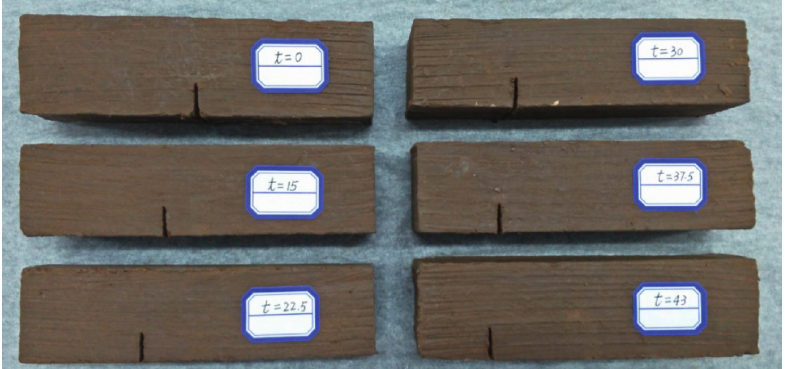
Figure 3: The prepared CCB specimens with different offset notches: C ˆ 0.717 ( t ˆ 43 mm), C ˆ 0.625 ( t ˆ 37.5mm), C ˆ 0.5 ( t ˆ 30 mm), C ˆ 0.375 ( t ˆ 22.5mm), C ) ˆ 0.25 ( t ˆ 15 mm), and C ˆ 0 ( t ˆ